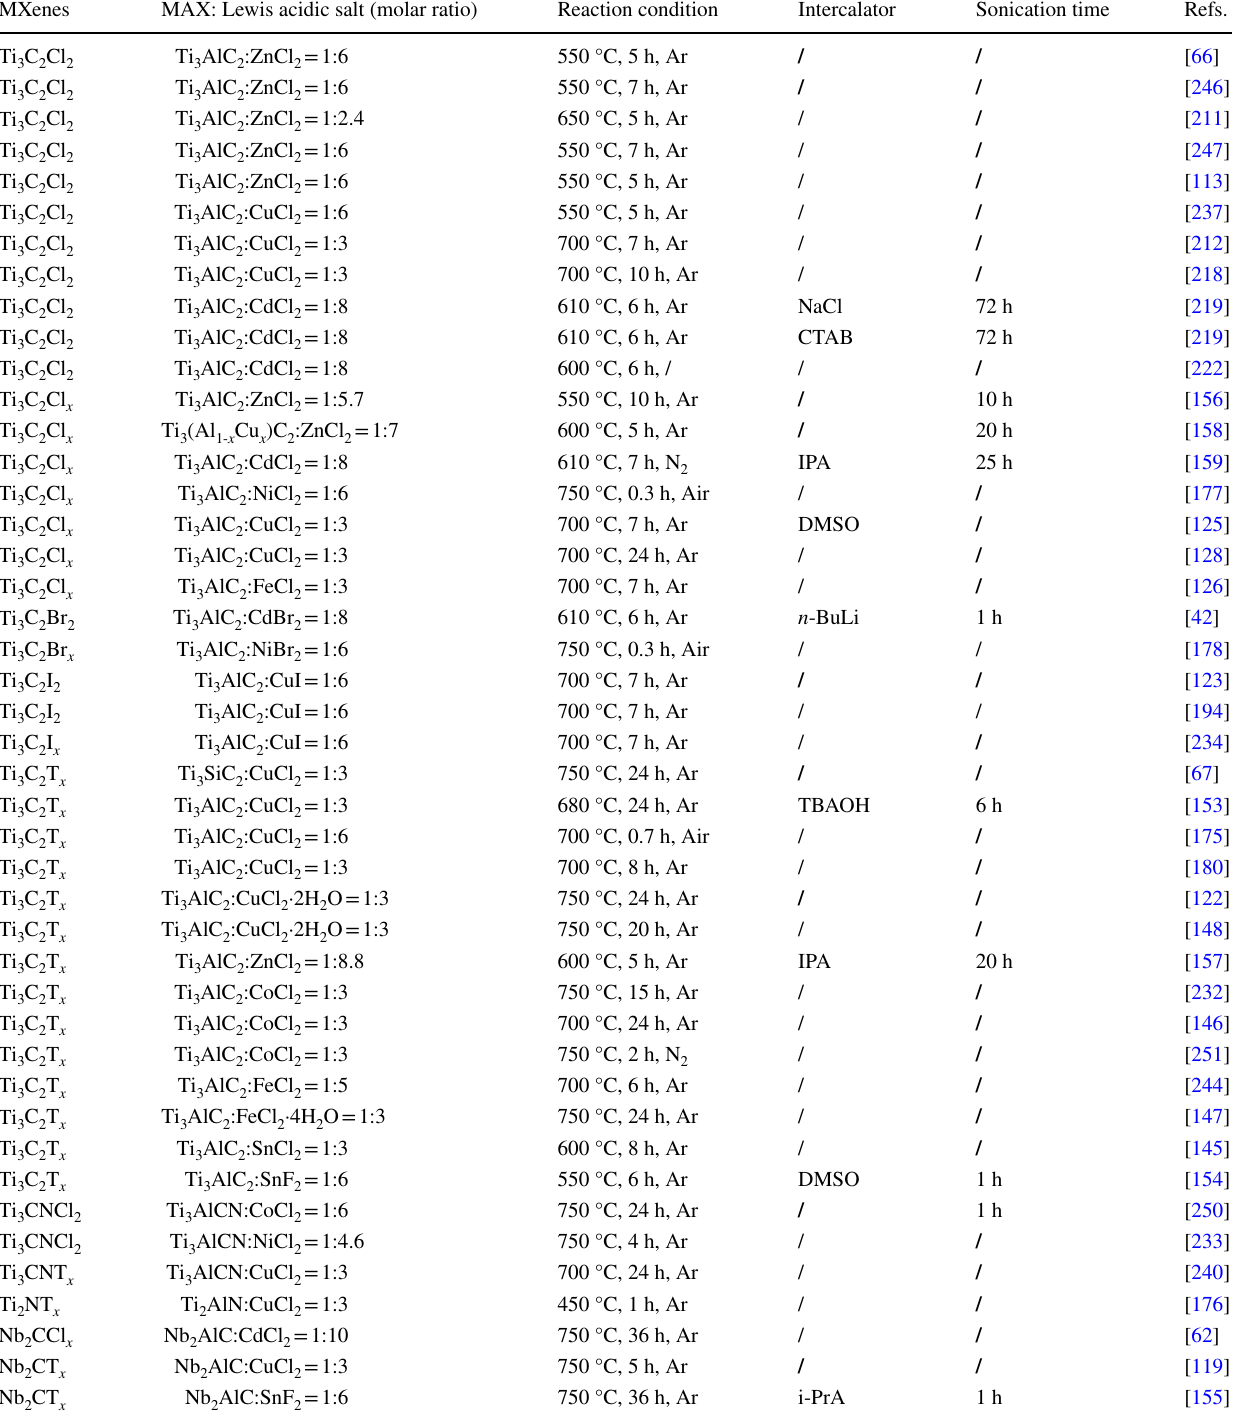
Table 2 The specific parameters for the preparation of various MXenes via Lewis acidic etching MXenes MAX: Lewis acidic salt (molar ratio) Reaction condition Intercalator Sonication time